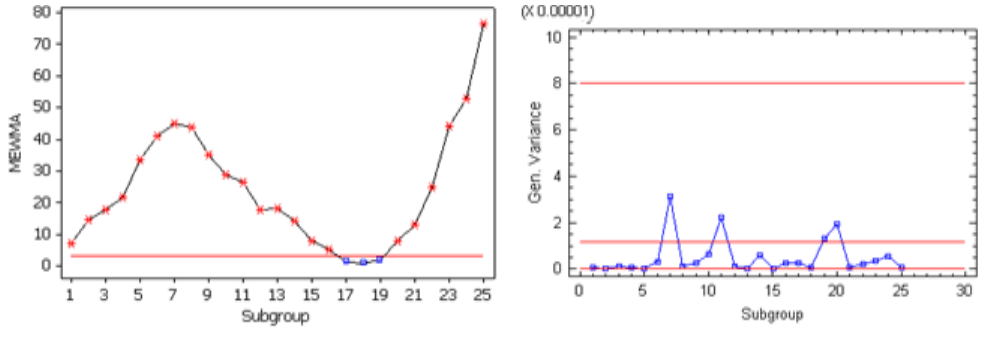
Figure 41. “Control ellipsoid for MEWMA chart for the primary